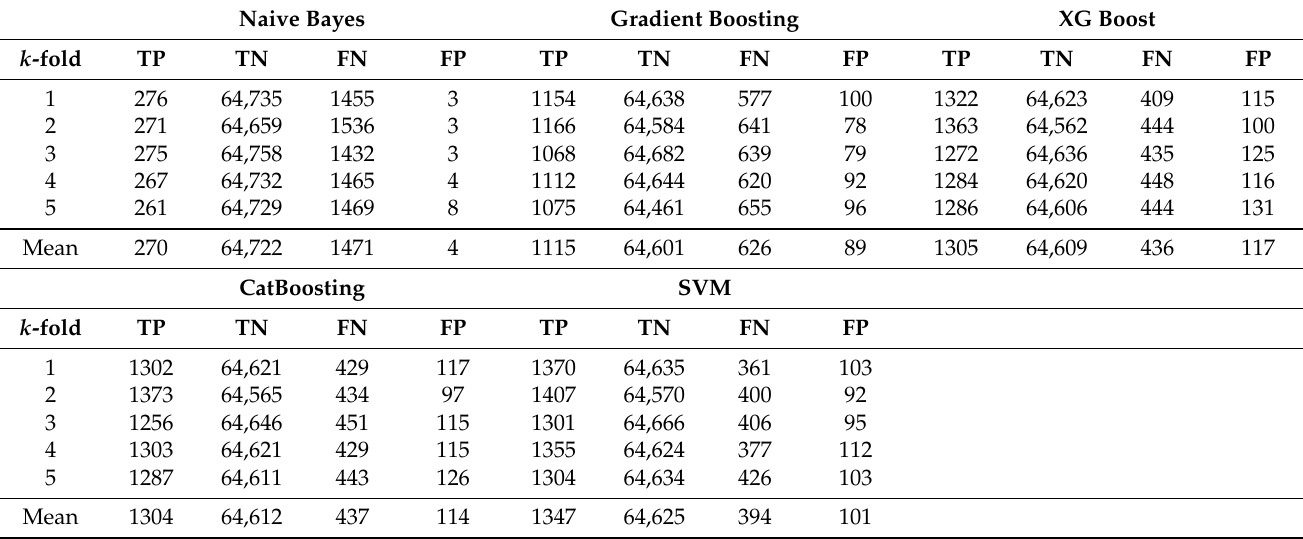
Table 5. The k -fold cross-validation with complete data (Combine_All as described in Section 3) segmented in into five folds. We split data into 80:20 splits for training and testing by ensuring the testing set did not contain any record from the training set. We applied ML models naive Bayes, gradient boosting, XGBoost, CatBoost and SVM.